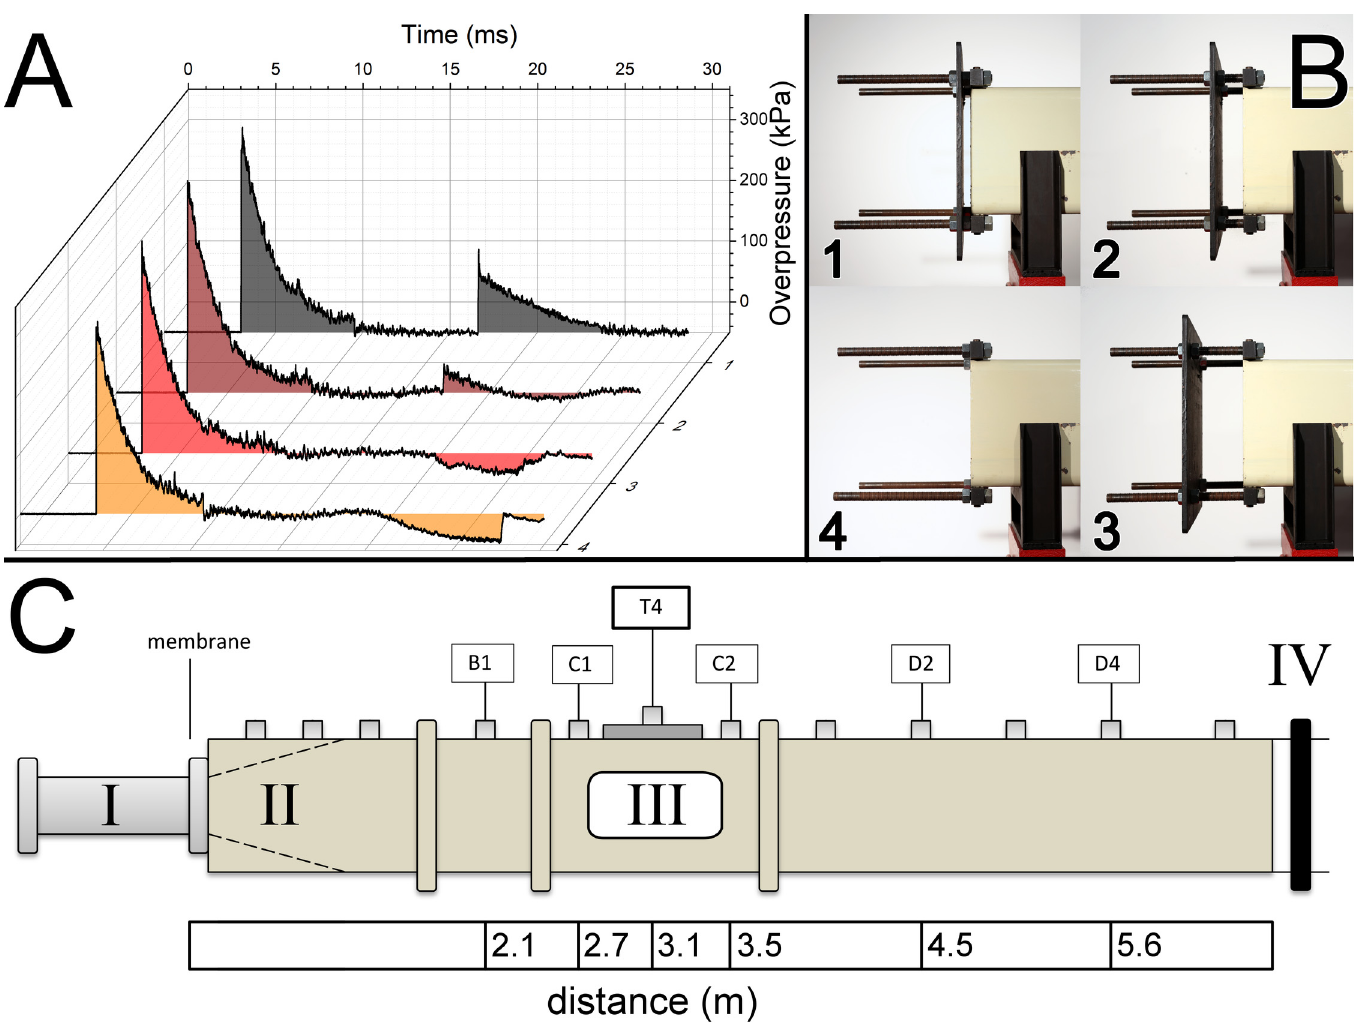
Fig 1. The representative incident shock wave profiles generated using helium as a driver gas and Mylar membrane (thickness of 1.016 mm), with accompanying secondary reflected shock and underpressure waves are presented (A). The profile of the secondary wave depends on the gap between the end plate reflector and the exit of the shock tube (B): 1. 0.625-inch, 2. 2-inch, 3. 4-inch, and 4. open end. C. Schematics of the 9-inch square cross section shock tube indicating the breech (I), transition (II), test section (III) and end plate (IV). Distribution of pressure sensor locations is also illustrated. Typically sensors B1, C1, T4, C2, D2 and D4 were used in our experiments to track the shock wave profile evolution along the entire length of the shock tube. The scale bar indicates the distance of specific sensor from the breech, i.e. Mylar membranes installation